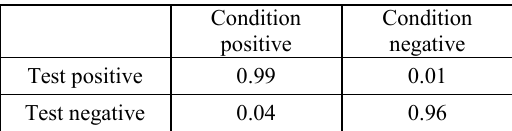
Table 7. Positive predictive value of the 19 Hz ANN